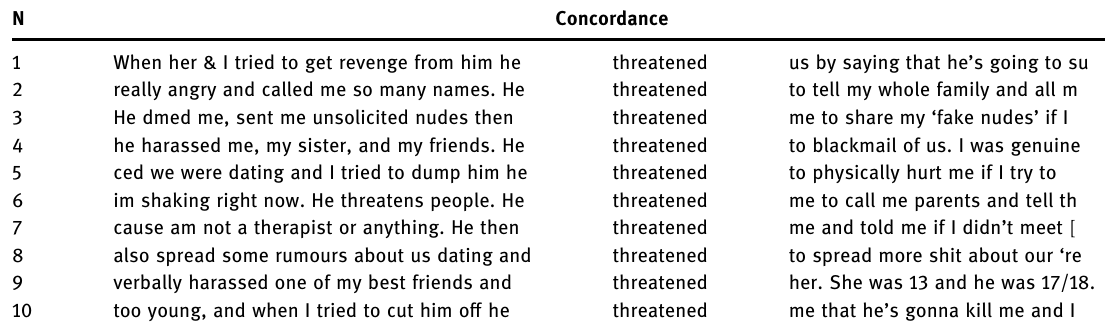
Table 37: Concordance lines for